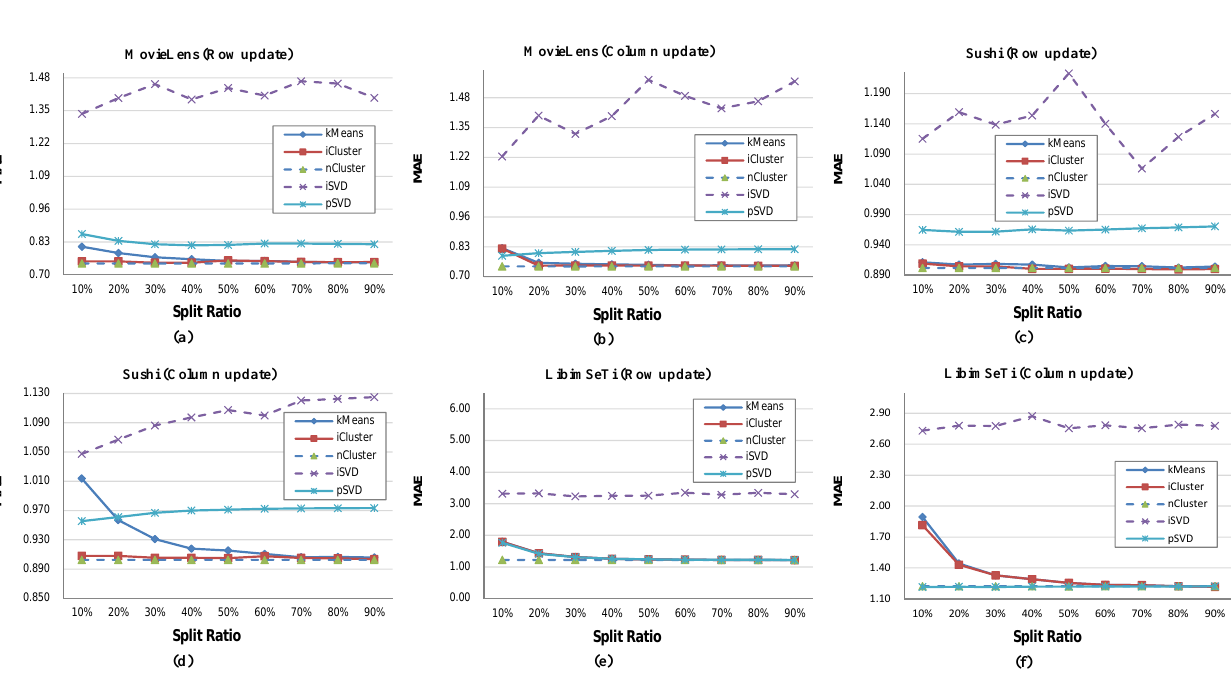
Figure 3. MAE variation with split